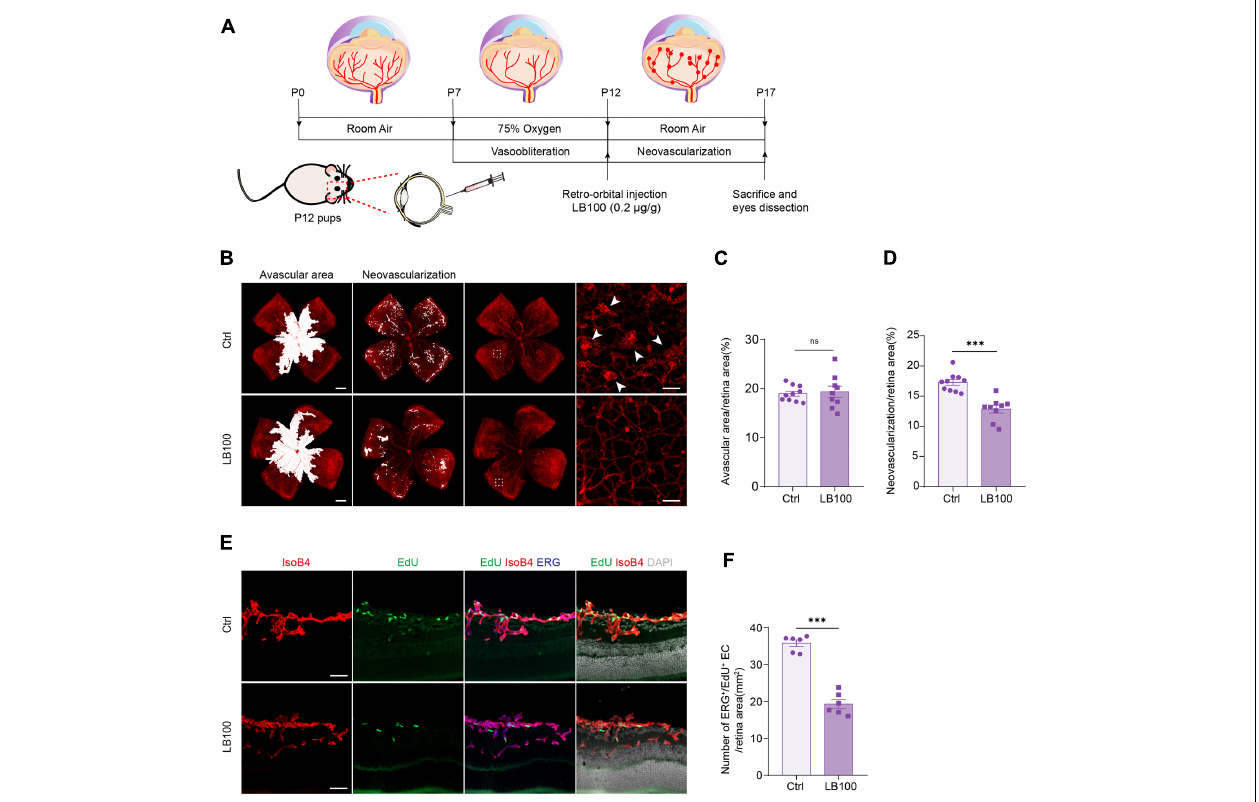
FIGURE 5 | PP2A inhibition suppresses pathological retinal angiogenesis in the OIR model. (A) Schematic depiction of the mouse OIR model. Pups were placed in 75% oxygen from P7 to P12, and then returned to normal oxygen conditions. Vehicle (Ctrl) or LB100 (0.2 µ g/g body weight) were injected retro-orbitally at P12. Pups were sacrificed and eyes were dissected at P17. (B) Representative confocal images of retina vasculature stained with IsoB4 in OIR retinas from vehicle (Ctrl) or LB100 treated pups. The avascular area, neovascularization area, and high magnification images for showing the neovascular tufts (indicated by arrowheads) are presented, respectively. (C,D) Avascular area and neovascularization quantification of (B) . n = 10 Vehicle and 9 LB100 eyes per condition. (E) Representative confocal images of retina sagittal sections costained with IsoB4, EdU (labels proliferating cells), and ERG (labels EC nuclei) in pups treated as in (A) . (F) Quantitative analysis of EdU + ERG + cell number of (E) . n = 6 Vehicle and 6 LB100 eyes per condition. Data are shown as mean ± SEM, two tailed Student’s t -test. ∗∗∗ p < 0.001, ns indicates not significant. Scale bars, 500 µ m (lower magnification) and 50 µ m (insets) in (B) , 50 µ m in (E) .